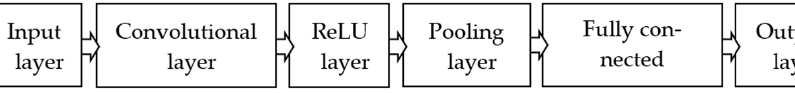
8 of 16 Figure 7. Bending moment spectrum under cutting (spindle speed: 2238 rpm). 2.4. Modeling Set-Up Before inputting the data into the ANNs for training, the parameters of each ANN were set. Parameters common to all the ANNs were the stride, learning rate, and batch size. The learning rate affects the number of strides, so that a lower learning rate requires more strides during training. In this study, the learning rate was set as 0.00015. The mean- square error (MSE) was used as the loss function to determine the training result, and the root mean-square error (RMSE) was further used to evaluate the test results. The training revealed that after a certain number of strides, the loss function and RMSE no longer changed significantly. After observing the convergence of the models, we set the stride to 1000 and the batch size as half of the training data. In total, 162 experimental data points were obtained. The training methods could be divided into training on all the data collectively and training on the classified data in turn. When training the classified data, we divided the data into three sets according to the three variances of the four factors (i.e., the cutting speed, feed per tooth, axial depth of cut, and radial depth of cut). Each set had 54 data points. The training result for each set of data was determined using MSE as the loss function, and four data points were randomly selected to test for accuracy with RMSE. Convergence was achieved after three tests, and the mean absolute percentage error was calculated. 2.4.1. Convolutional Neural Network (CNN) A CNN is a type of deep learning model that is mainly used for image recognition. It can effectively conduct feature identification and learning, as well as data analysis, mini- mizing the data size. It comprises an input layer, multiple hidden layers, and an output layer. The hidden layers are composed of convolutional layers, pooling layers, and fully connected layers. The convolutional layers are mainly responsible for feature extraction and can achieve superior spatial feature learning. The pooling layers filter feature data and retain the essential features to downsize the data, effectively reducing the difficulty of the training. The input data for this study were obtained in time series order. Time series data are suitable for storage as a one-dimensional matrix. Thus, for the CNN model, we set the number of input channels to one and the input data format as a 1-by-2500 matrix. In order